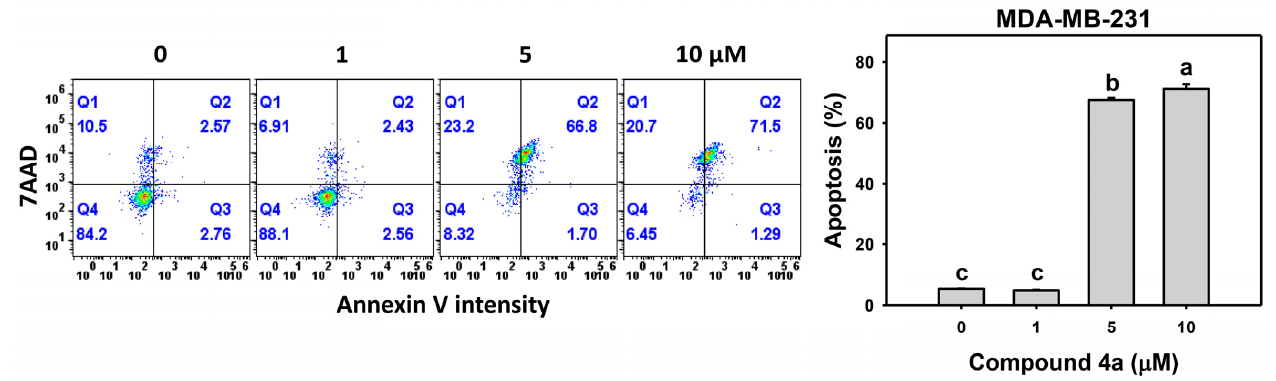
Figure 3. Upregulation of annexin V-based apoptosis of breast cancer cells by compound 4a . MDA-MB-231 cells were treated with 4a for 24 h, and their apoptosis status was determined by flow cytometry. Populations of annexin V (+)/7AAD were assigned as apoptosis (+) (%). Data, means ± SDs ( n = 3). Data containing non-overlapping notes exhibited significant differences ( p < 0.05). The letters (a, b, c) were provided by the statistical JMP software for determine significance. “a” is the biggest value and others follow the order.